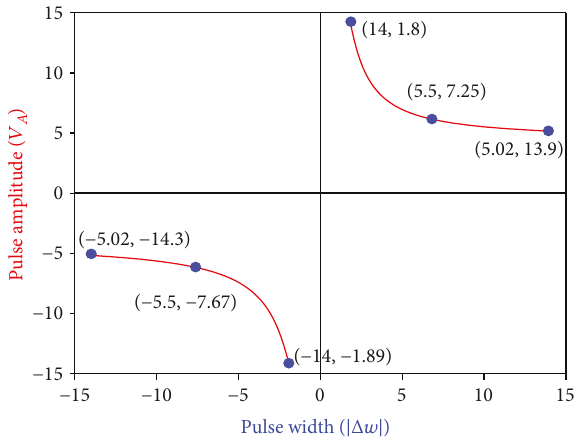
Figure 9: Relationship between the pulse amplitude V width Δ w for the switching kinetics of the 6-lobe corsage